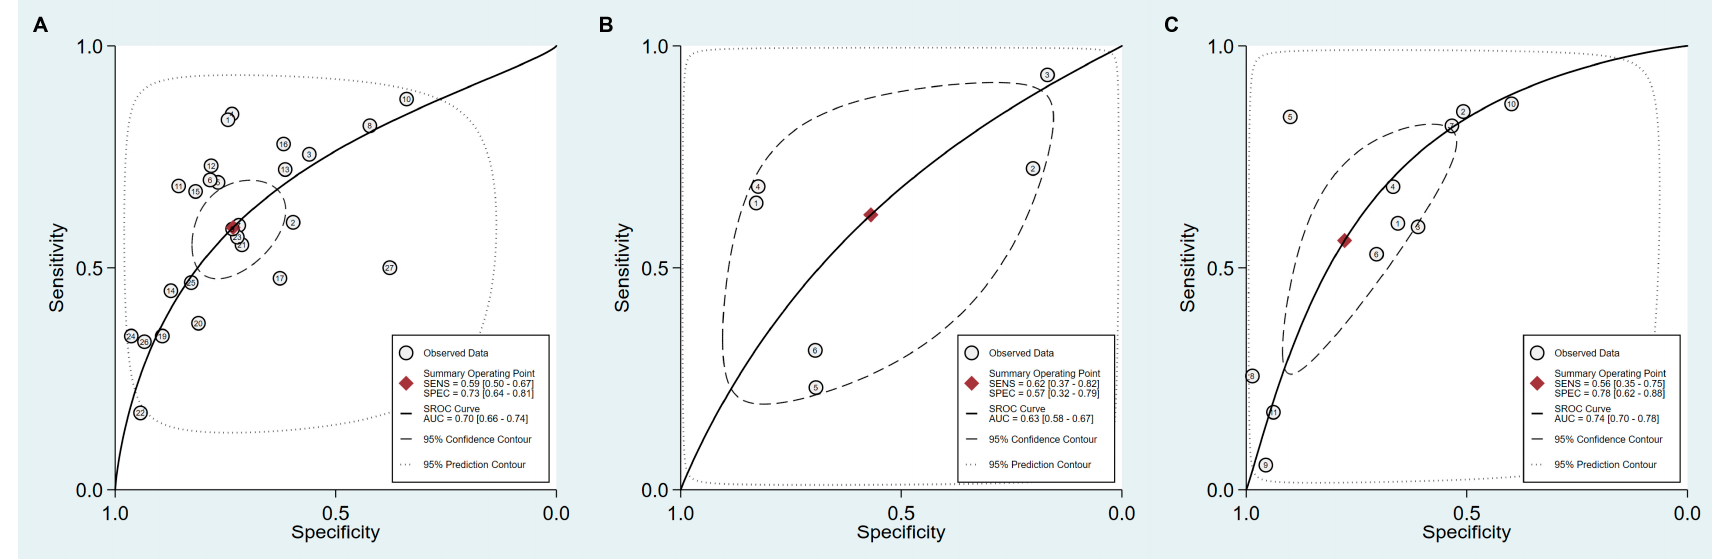
Figure 8. SROC curve with 95% confidence region and prediction region for the diagnosis of GC. ( A ) cut-off value with PG I ≤ 70 ng/mL and PG I/PG II ratio ≤ 3, ( B ) cut-off value with PG I ≤ 70 ng/mL, ( C ) cut-off value with PG I/PG II ratio ≤ 3. SROC, summary receiver operating characteristic; GC, gastric cancer; PG, pepsinogen.